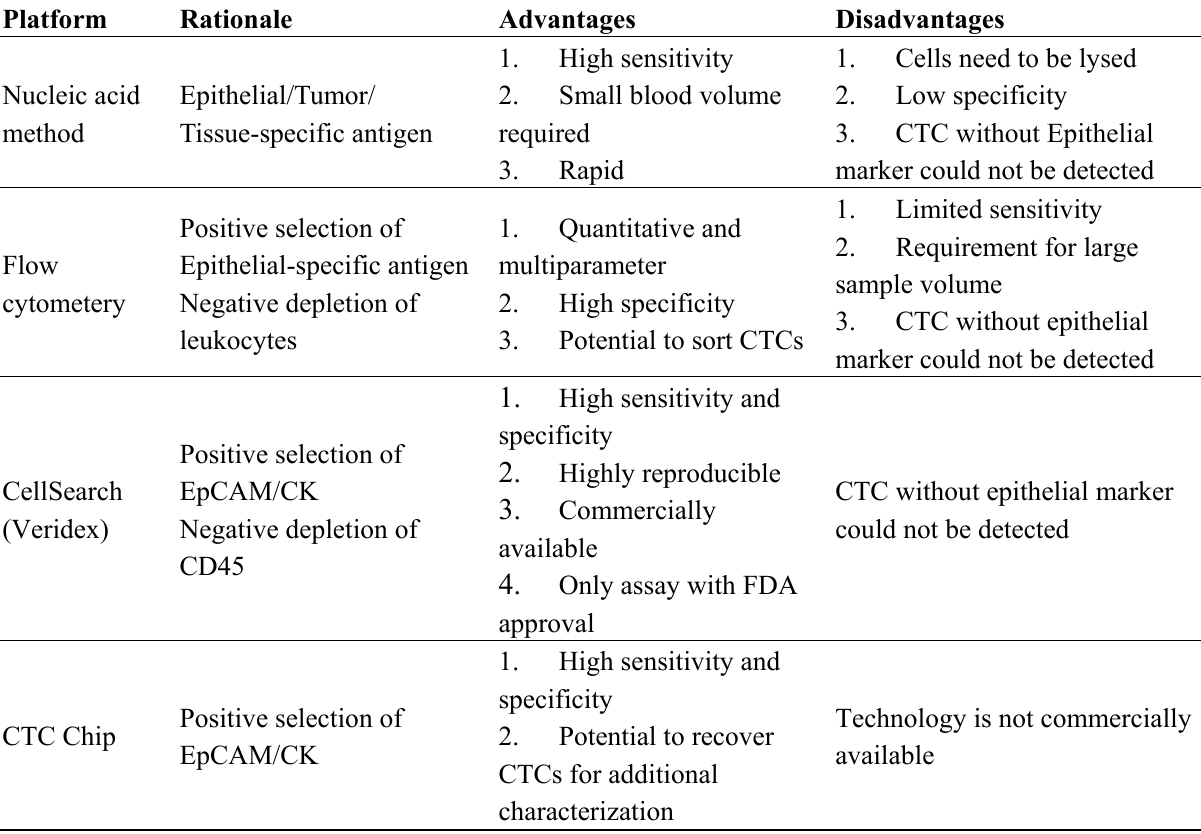
Table 3. Advantages and disadvantages of CTC detection